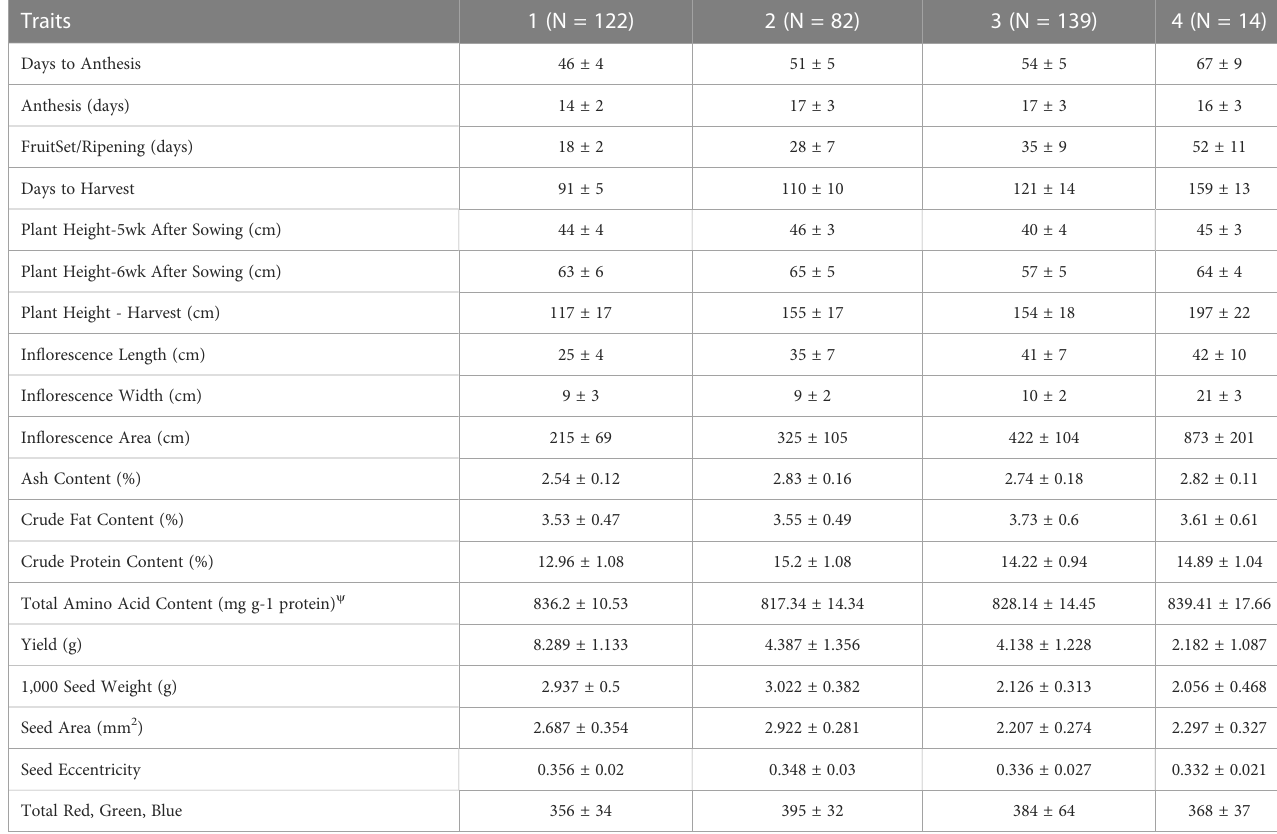
TABLE 5 Mean values plus and minus (±) standard deviation reported for each trait within each of the clusters (N =4). Traits